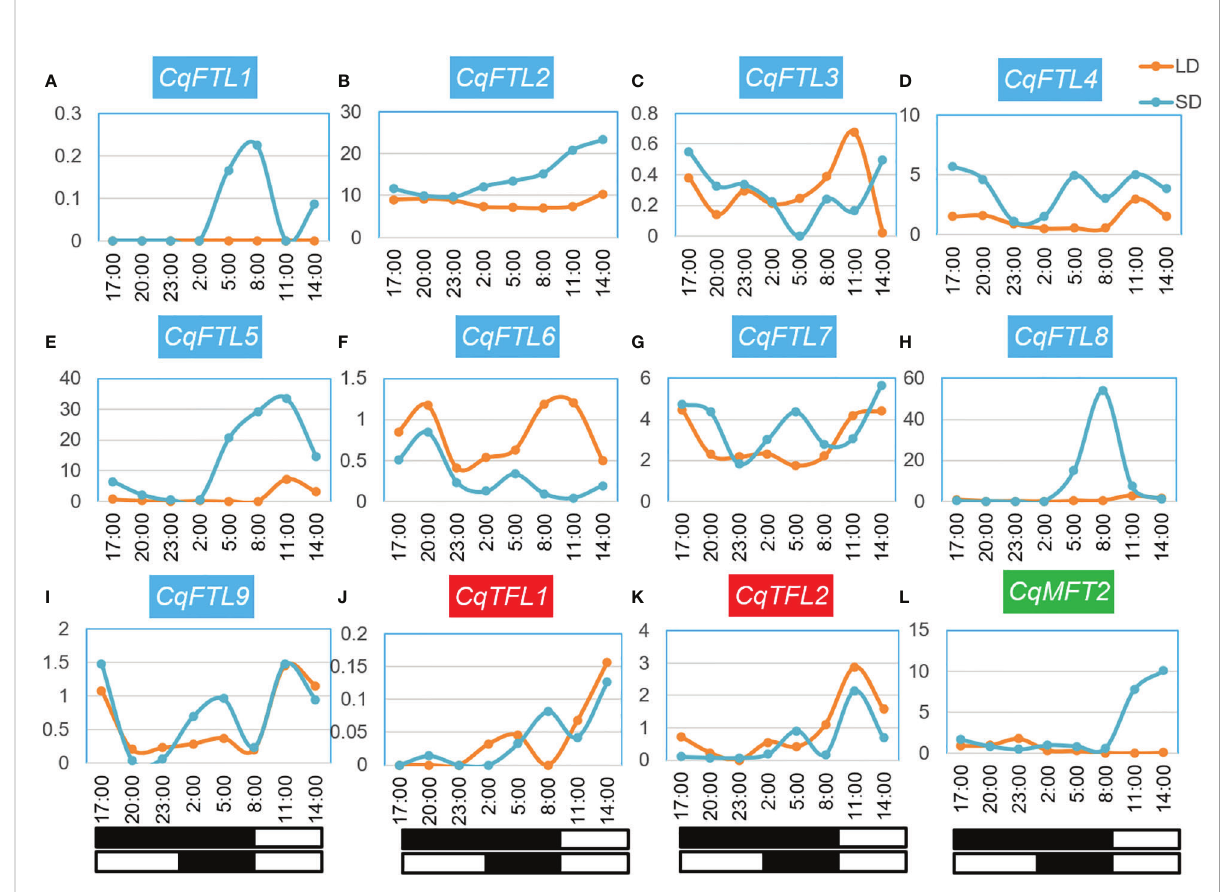
FIGURE 11 Diurnal expression patterns of PEBP s under short-day and long-day conditions. (A-L) Expression patterns of CqFTL1 , CqFTL2 , CqFTL3 , CqFTL4 , CqFTL5 , CqFTL6 , CqFTL7 , CqFTL8 , CqFTL9 , CqTFL1 , CqTFL2 and CqMFT2 under short-day and long-day conditions. Two-week-old plants grown under short-day and long-day conditions were used to collect the leaf samples, respectively, at 17:00, 20:00, 23:00, 02:00, 05:00, 08:00, 11:00 and 14:00. RNA-seq analysis was performed to investigate the expression patterns of PEBP s. White and black boxes indicate day and night time, respectively. Each expression value was generated from two replicates. Orange and blue curves stand for the expression levels of PEBP s under long-day and short-day